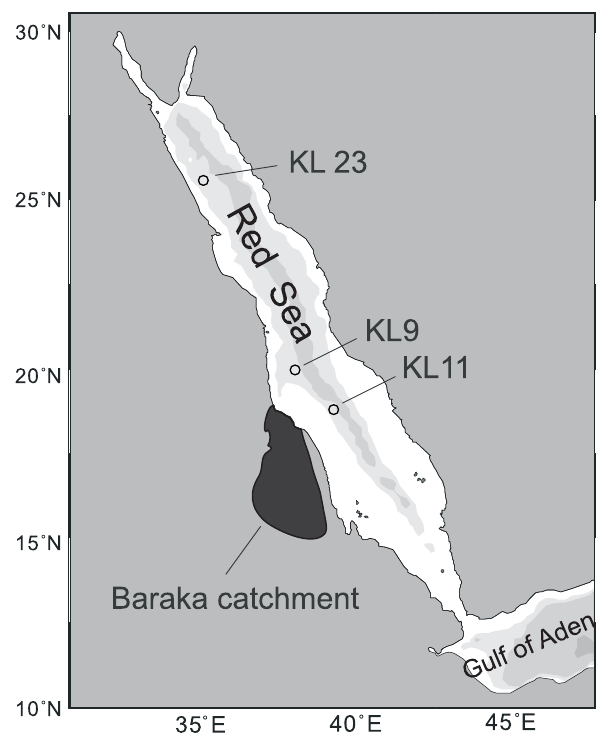
Fig. 1. Map of the Red Sea with the investigated cores KL23 (Geiselhart, 1998; Schmelzer, 1998), KL9, and KL11, highlighting the position of the seasonally active Baraka